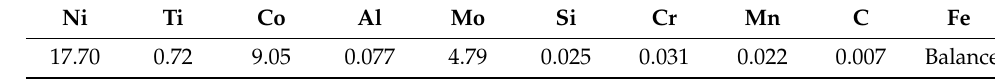
Table 1. Chemical composition of the 18Ni300 powder (mass%).